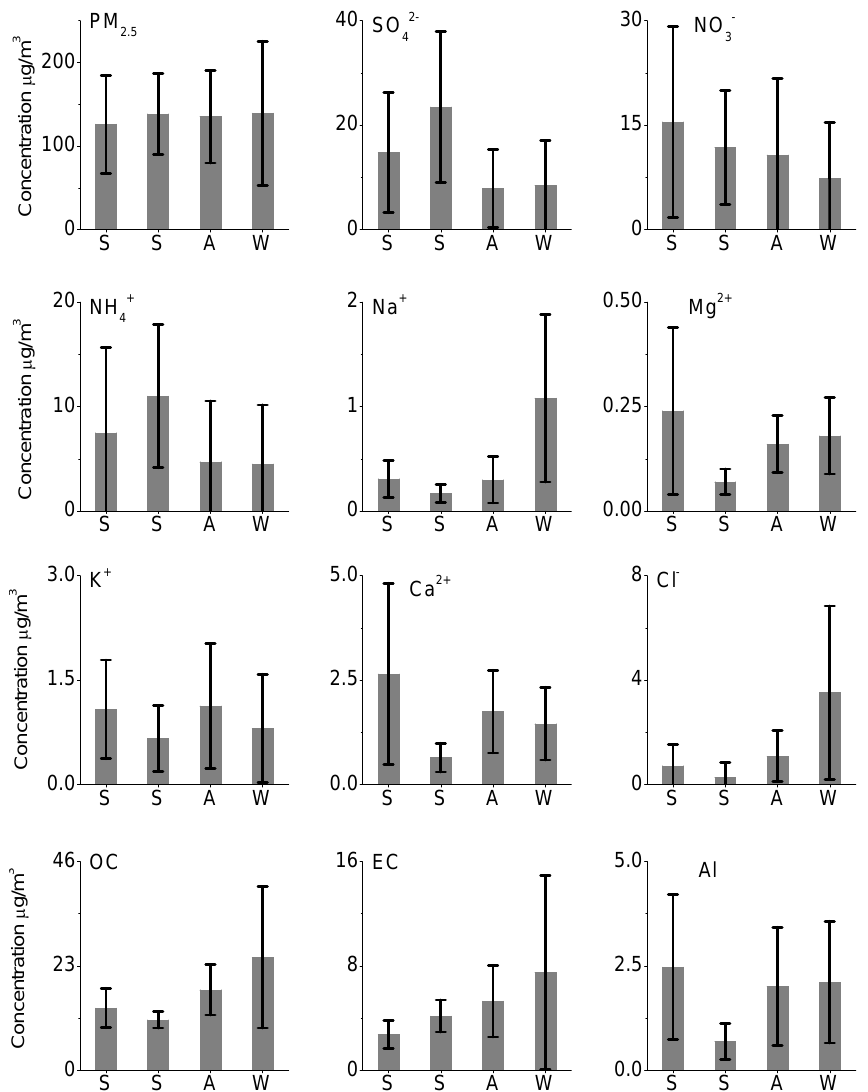
Fig. 2. Seasonal variations of PM 2 . 5 mass concentration and associated species, including SO 2 − OC, EC, and Al concentrations. Shown here are the mean and one standard deviation for each bar.